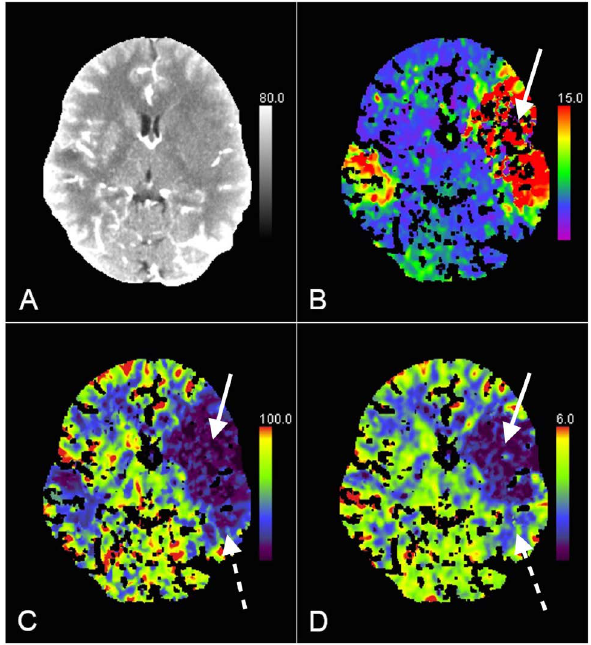
Fig. 1. Computed tomography (CT) scan with contrast (A) and CT perfusion parametric maps with time to peak (B), cerebral blood flow (C), and cerebral blood volume (D), demonstrate occlusion of the left middle cerebral artery M1 segment with a core infarct (ar- row) involving the basal ganglia mid frontal lobe, insular cortex, and the anterior temporal lobe. Ischemic penumbra (dashed arrow) was seen more distally at the parietal lobe indicating collateraliza- tion from the anterior cerebral artery and posterior cerebral artery territories. By convention, all color maps are coded red for higher values and blue for lower